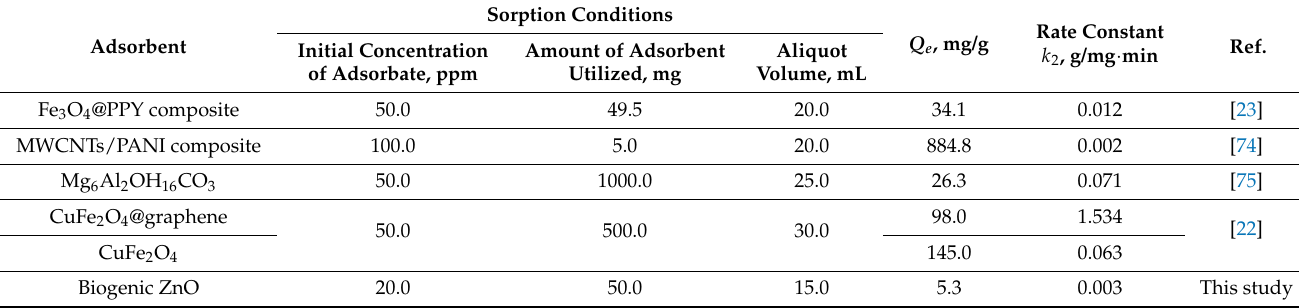
Table 5. Comparison of the AY adsorption capacity of Serratula coronata L. mediated ZnO NPs and some other available